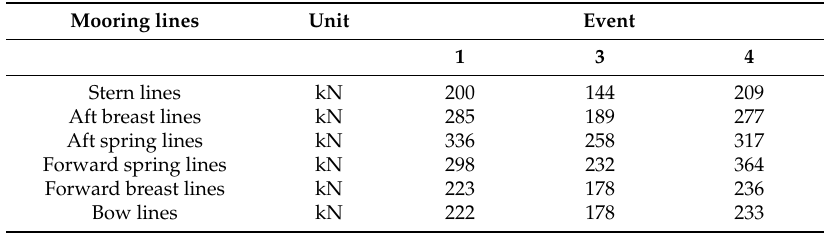
Table 5. Maximum mooring line forces for the Base Case.